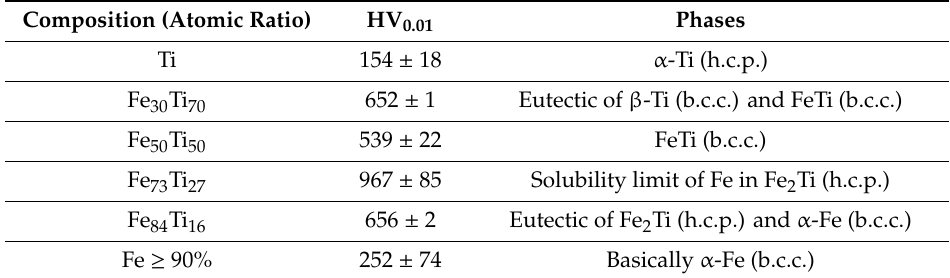
Table 2. Compositions obtained by EDS point analyses with corresponding microhardness and possible phases with their crystalline structure that can be found in the Fe-Ti phase diagram in Figure 1. Composition (Atomic Ratio) HV 0.01 Phases